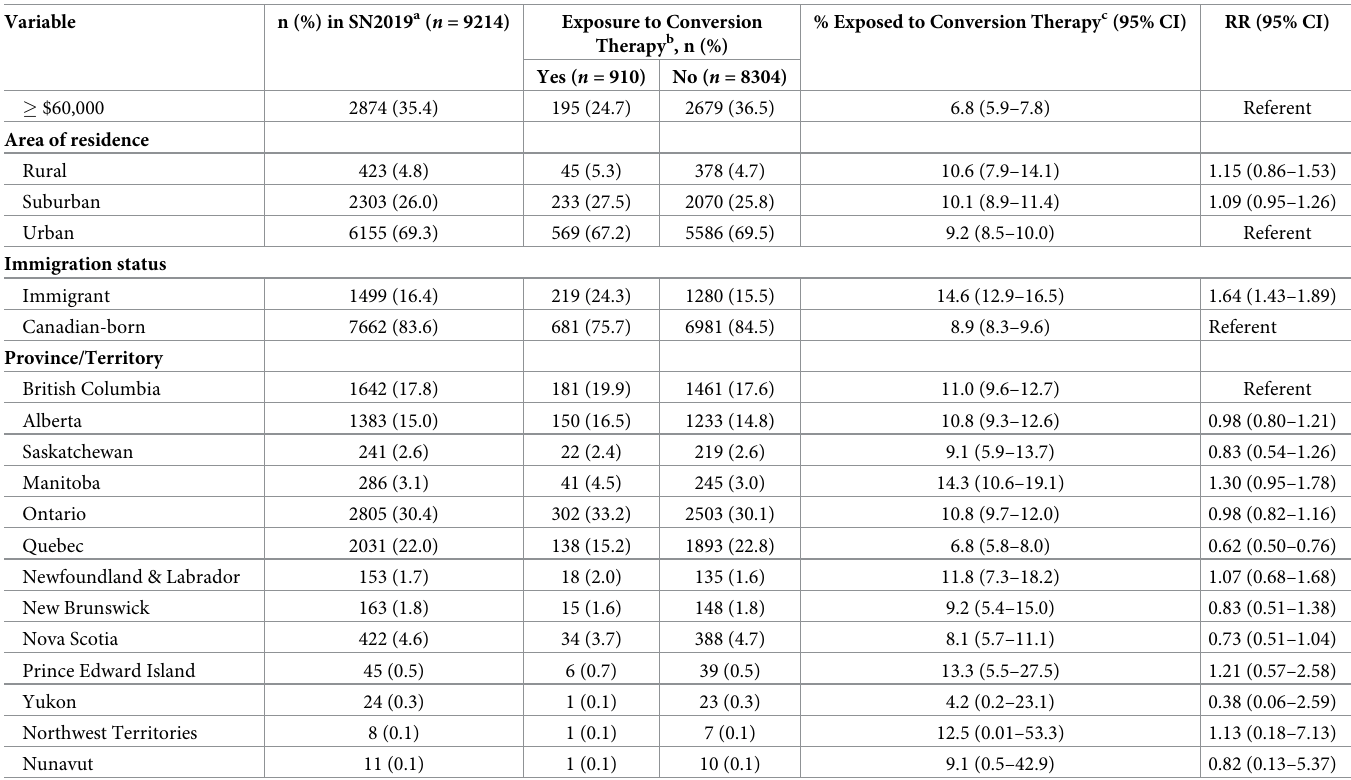
( Table 2 ). Asexual participants (35.1%) and those without a college/university degree (23.4%) Quebec (14.3%) and Saskatchewan (17.6%) reported lesser SOGIECE exposure than those liv- ing in British Columbia